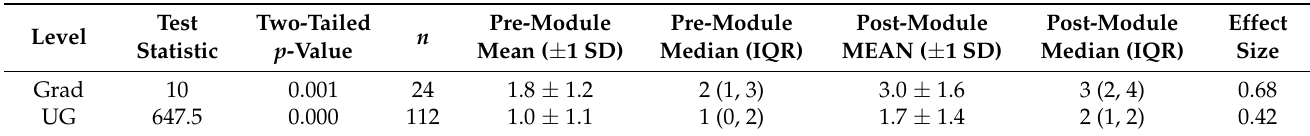
Table A6. Differences in the number of INTEF cycle steps included in students’ responses to Question 5, “Let us pretend that you are an ecological forecaster tasked with forecasting lake algae concentra- tions for the next 16 days into the future to help lake managers. What steps would you propose to accomplish this goal? If you don’t know the answer, please write ‘I don’t know’ instead of leaving the response blank” between pre- and post-module assessments for graduate (Grad) and undergraduate (UG) students. Test statistics and p -values are for paired, two-sided Wilcoxon signed-rank tests; pre- and post-module means are reported with the standard deviations (SD) along with pre- and post-module medians and the interquartile range (IQR). Significant p -values ( p < 0.5) are shown in bold.